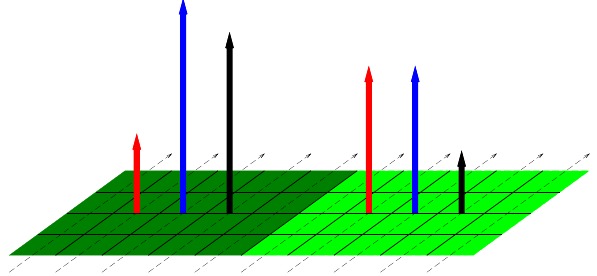
Fig. 1. Schematic overview of the heterogeneous surface conditions for the numerical experiments performed by DALES. The simulated domain is split into forest and savannah patches. Over the rela- tively cold and wet forest patch the sensible heat flux is lower than over the relatively warm and dry savannah patch, but the latent heat flux is higher. The emission of isoprene is highest over the forest. Over the whole domain the total isoprene emission and surface heat fluxes are kept the same as the case with homogeneous surface con- ditions. For both terrains the sum of the latent and sensible heat fluxes is the same. Generated statistics are averaged in the direction perpendicular to the direction of heterogeneity.